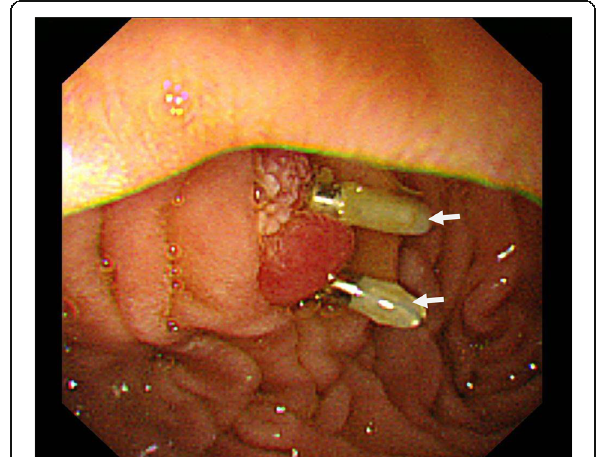
Fig. 5 In order to prevent duodenal bleeding or perforation, the penetration site was repaired by EGD clippings